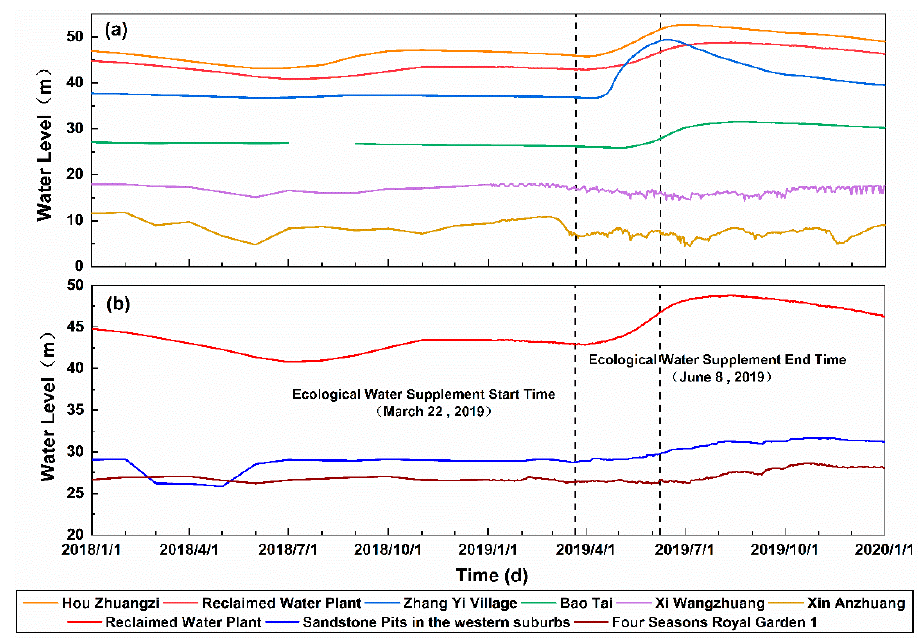
Figure 2. ( a ) Dynamic curve of the groundwater level of the monitoring wells along Yongding River. ( b ) The dynamic curve of the groundwater level of monitoring wells at different distances, with a perpendicular arrangement to the Yongding River.